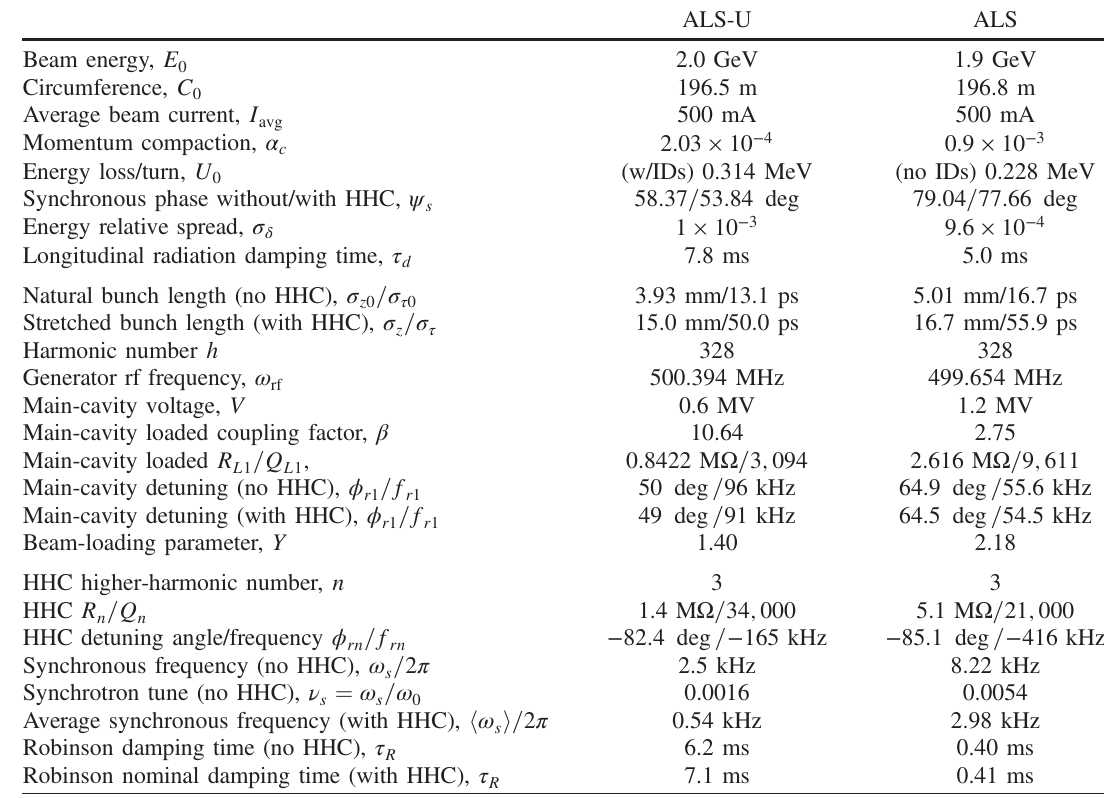
TABLE I. Relevant ALS-U and ALS